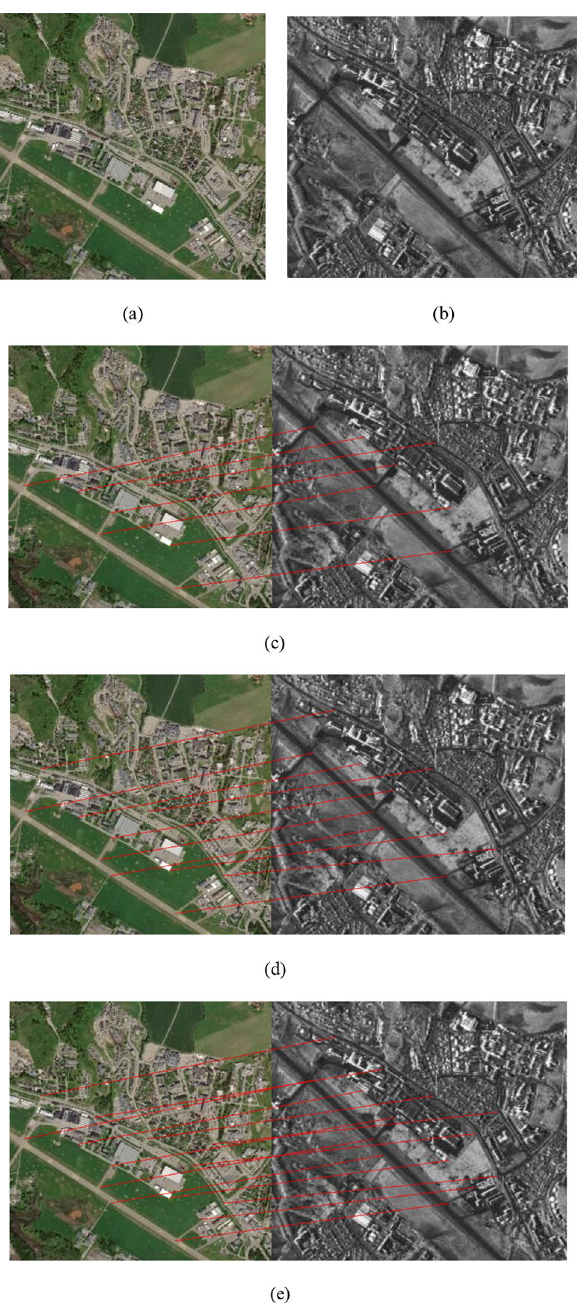
Figure 2. ( a ) Optical image; ( b ) SAR image; Matches found in pair 2 using ( c ) PSO-SIFT, ( d ) OS-SIFT, and ( e ) the proposed method. The reference image is shown on the left and the sensed image on the